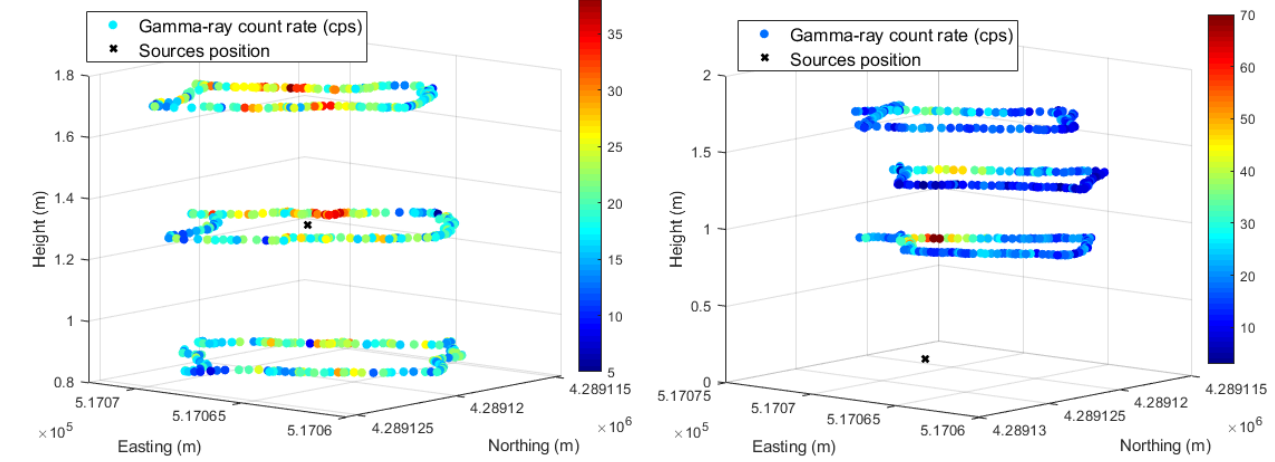
Figure 28. A 3D view of the EJ-200 scintillator gamma-ray count rate (cps) measurements considering the 137 Cs sources of 4 MBq in the center ( left figure) and at the bottom corner ( right figure) of the shipping container. The true position of the sources is indicated by an “x”